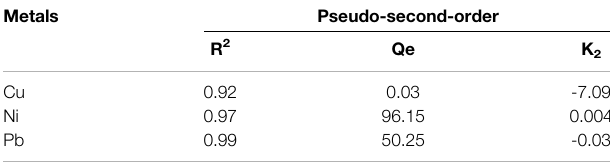
TABLE 3 | Kinetics results for the removal of metals in the PANI-WH